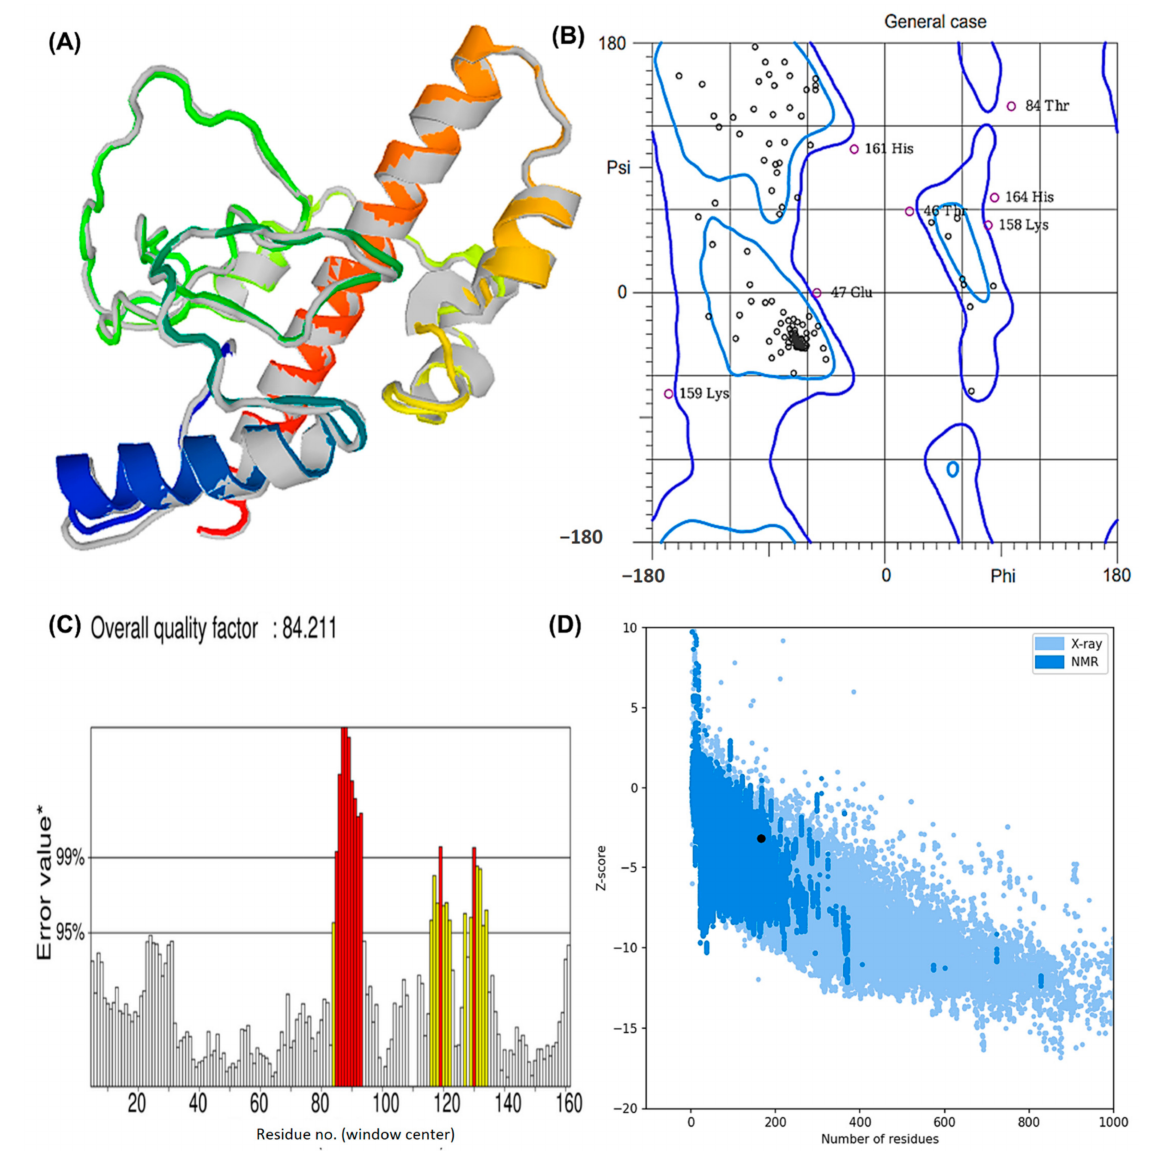
Figure 4. The modeled assembly and the quality check investigation of the designed MEV against Lyme borreliosis ( A ) refined model after GalaxyRefine and ModRefiner. The gray parts of the structure represent the areas refined by the tools ( B ) Rama plot analysis exhibiting residues in the favored, allowed, and disallowed region. Areas encircled by the light blue and dark blue colors are the favoured and allowed regions respectively. ( C ) ERRAT score depicting a quality factor of 84.21 ( D ) Z-plot showing a Z-score of −